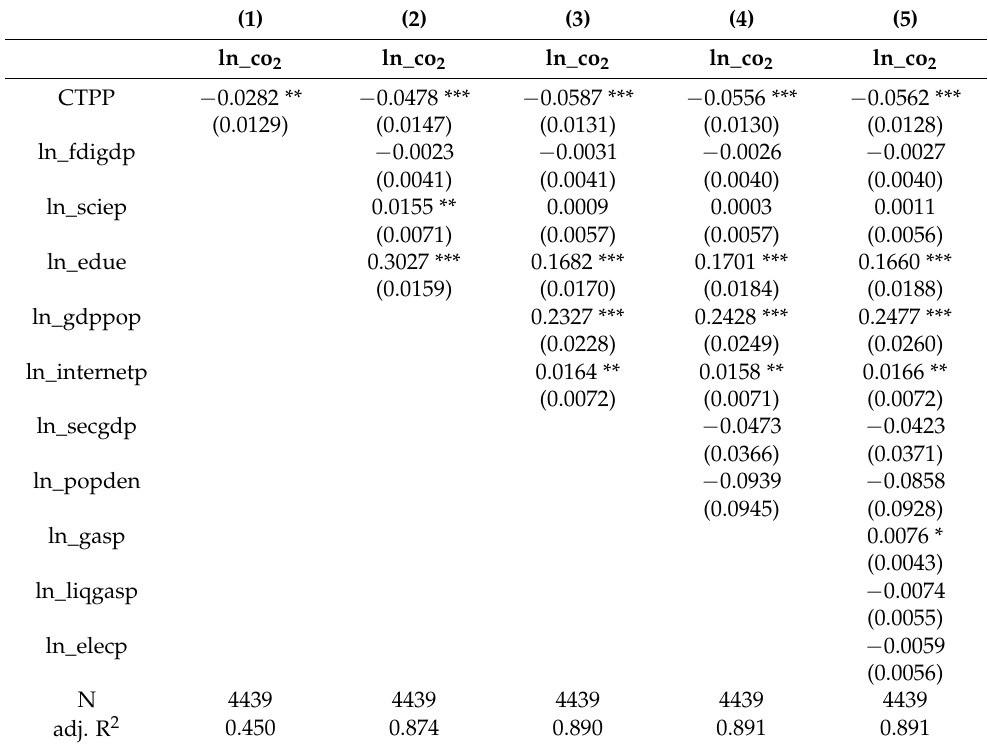
Table 5. PSM-DID regression results.